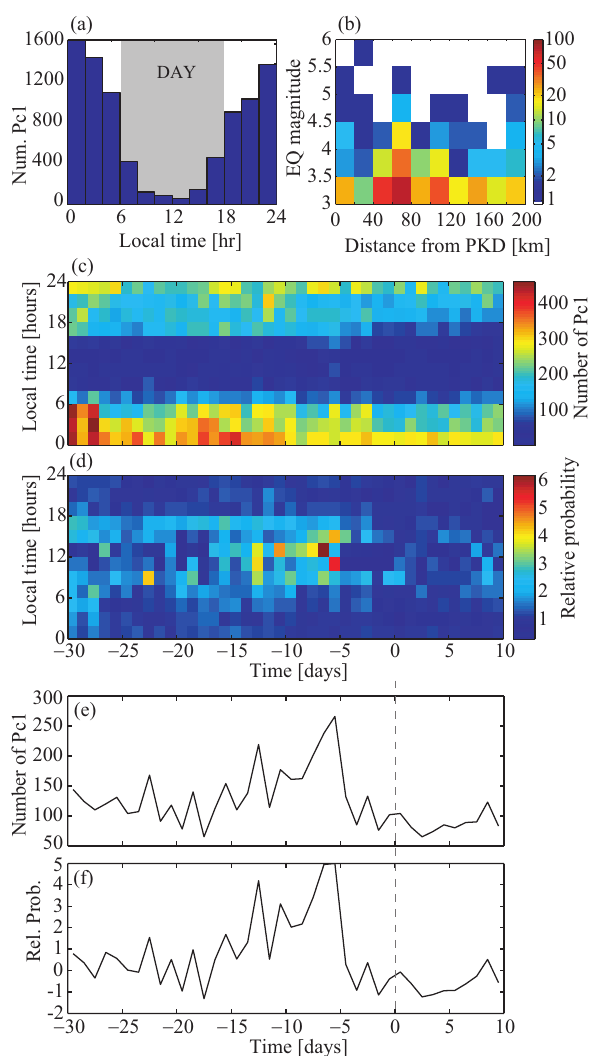
Fig. 3. (a) Distribution of 8,193 Pc1 pulsations as a function of local time. (b) Distribution of 434 earthquakes during the period under consideration, as a function of magnitude, and distance from our search-coil. (c) Superposed epoch analysis of Pc1 events observed within − 30 to + 10 days of our 434 earthquakes, as a function of 1T and LT. (d) Relative probability of observing Pc1 pulsations in the same format as (c). (e) Number of Pc1 pulsations observed on the day side, 08:00–16:00LT, corresponding to panel (c). (f) Same as (e), but corresponding to panel